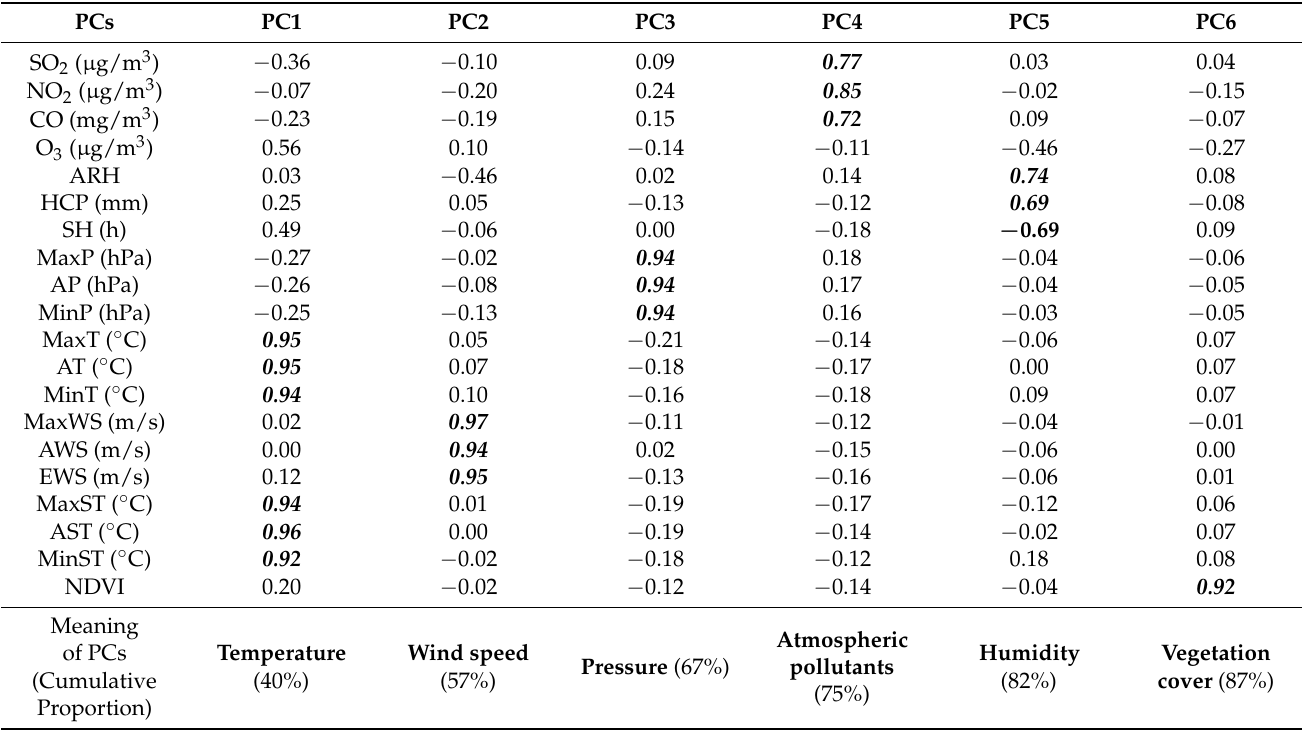
Table 2. Principal component loadings of each PC after the maximum variance orthogonal rotation